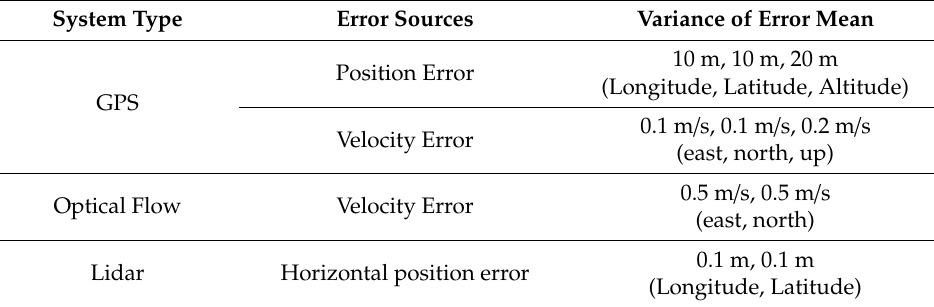
Table 2. Parameters of